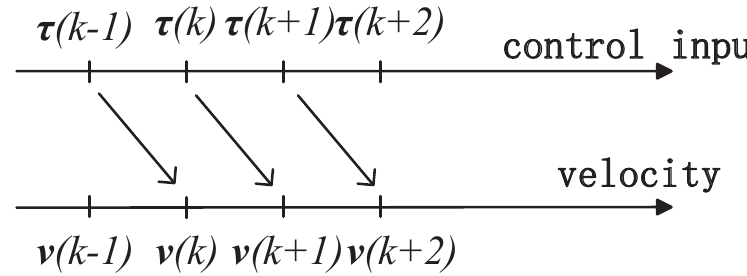
Figure 3. Schematic diagram of the transformation from control input to velocity.